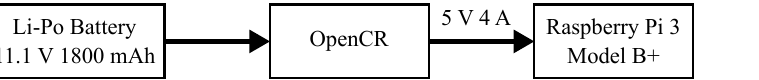
Figure 5. Power supply of the window scanning robot. The robot has an 11.1 V 1800 mAh Li-Po battery for the power supply to OpenCR. From OpenCR, 5 V 4 V power is supplied to Raspberry Pi